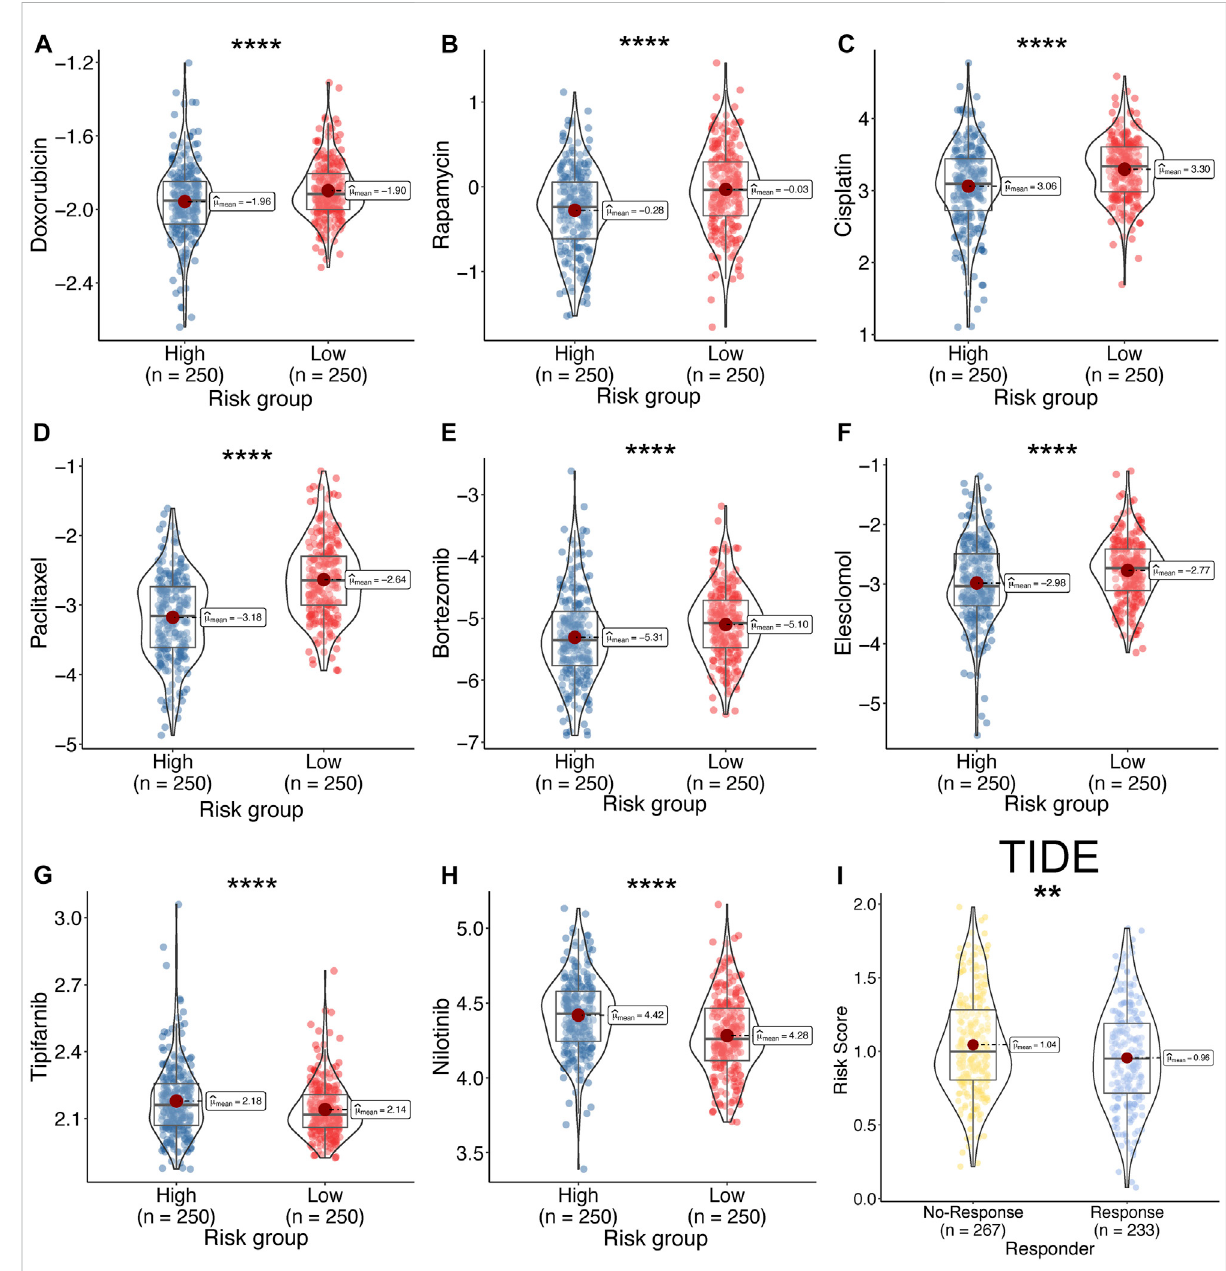
FIGURE 11 Drug sensitivity between high- and low-risk. (A – H) Calculate the half-maximal inhibitory concentration of FDA-approved drugs in the risk model, including, Doxorubicin (A) , Rapamycin (B) , Cisplatin (C) , Paclitaxel (D) , Bortezomib (E) , Elesclomol (F) , Tipifarnib (G) , and Nilotinib (H) . (I) Response rate between high- and low-risk group by TIDE algorithm in TCGA-LUAD